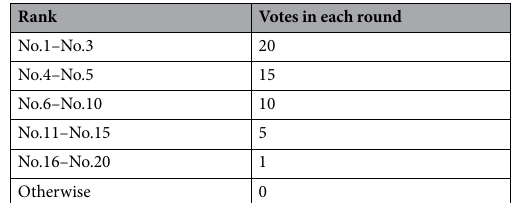
Table 6. Voting strategy at step